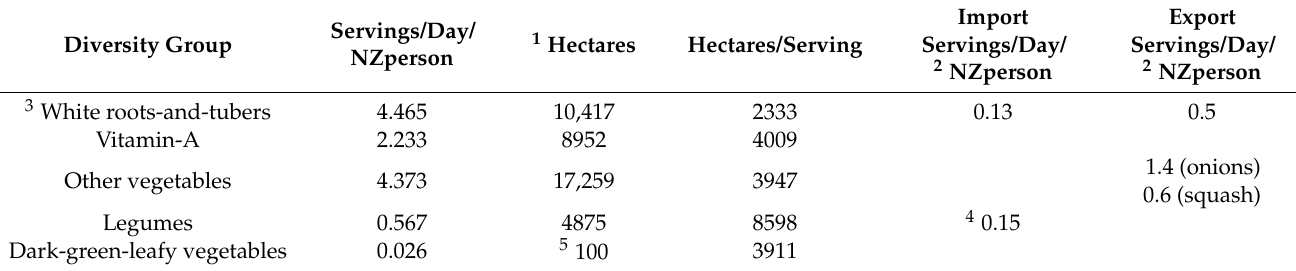
Figure 2. Seasonal variation in price of one kilogram of 19 vegetables from June 2020 to June 2021. Source statistics NZ consumer price index [25]. Table 3. Vegetables grown in New Zealand by dietary diversity group and servings/day/NZperson in the population, area of land used, and imports and exports of vegetables